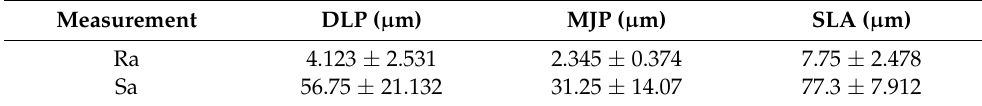
Table 8. Mean surface roughness ((mean ± SD) µ m) on surface of 3D-printed models. Measurement DLP ( µ